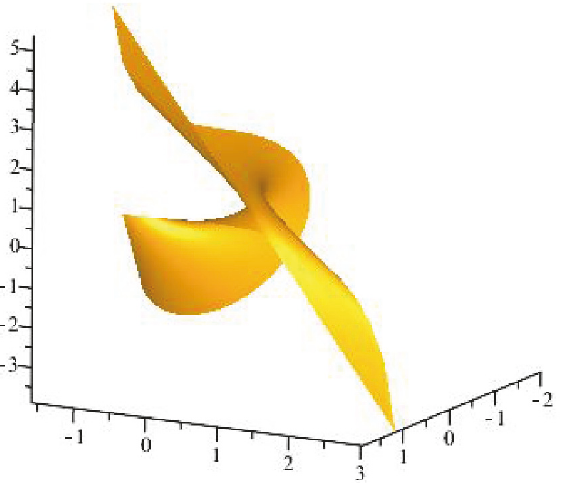
Figure14:Projectionoftheintersectionof IH 𝛾 ± (𝑠,𝜇,𝜔) and 𝜔 = 0 on 𝑥 2 𝑥 3 𝑥 4